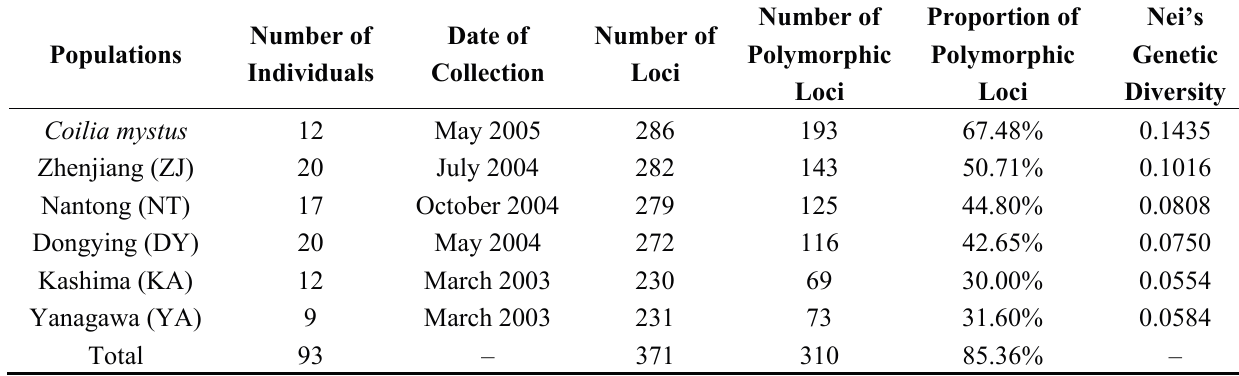
Table 1. Parameters of genetic diversity for populations of Coilia nasus and Coilia mystus.